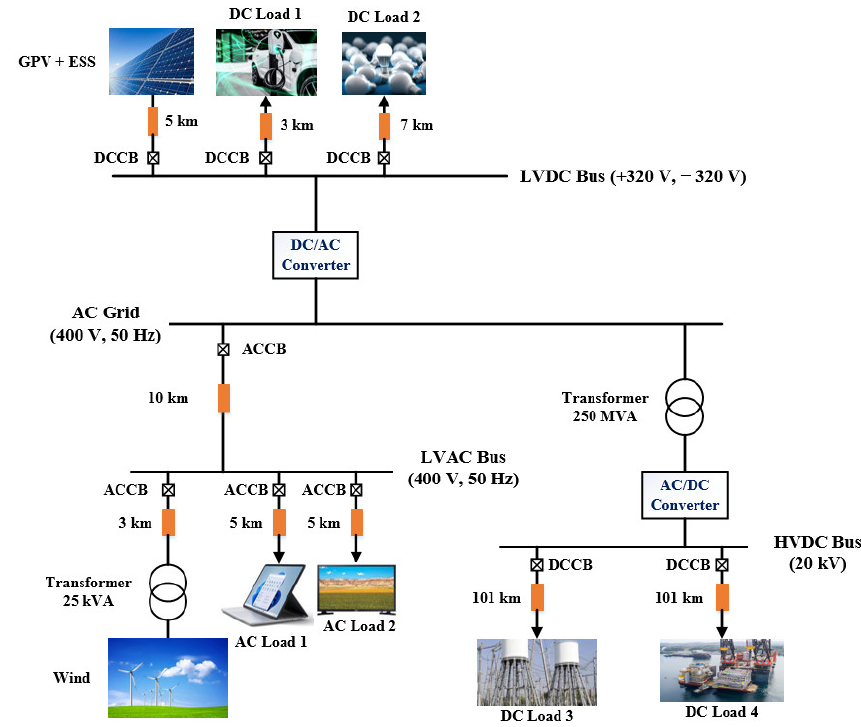
Figure 12. Four buses novel hybrid network test.